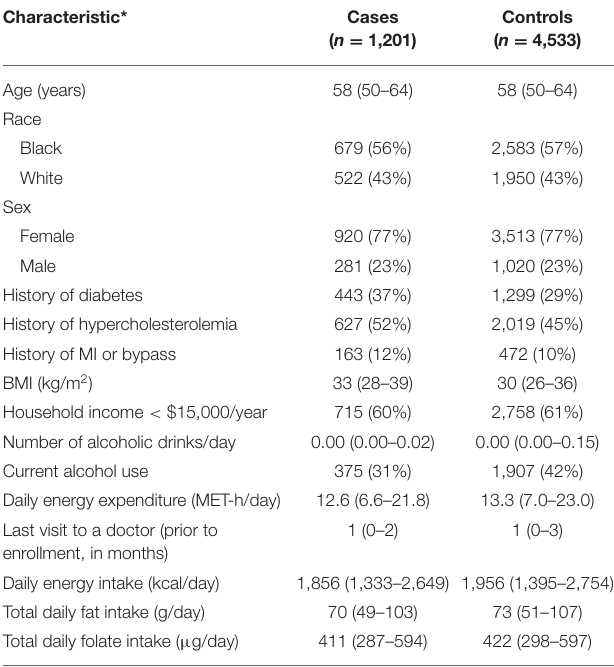
TABLE 1 | Baseline characteristics of participants in the Southern Community Cohort